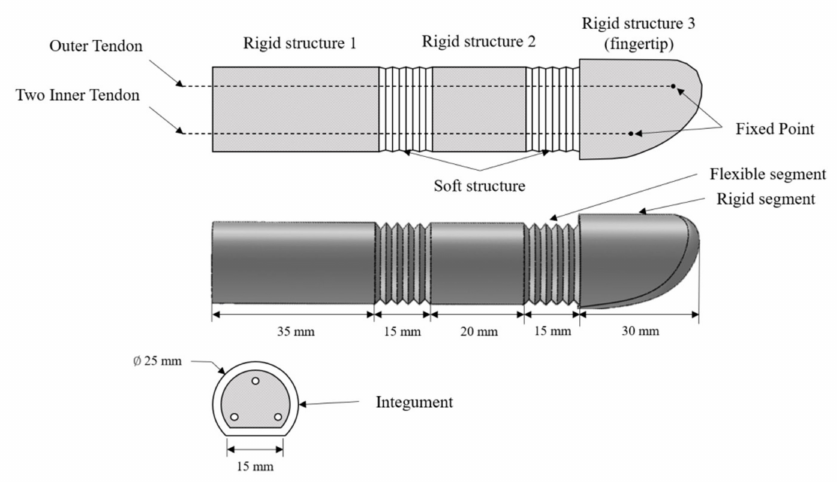
Figure 1. Illustrative schematic of the variable-stiffness